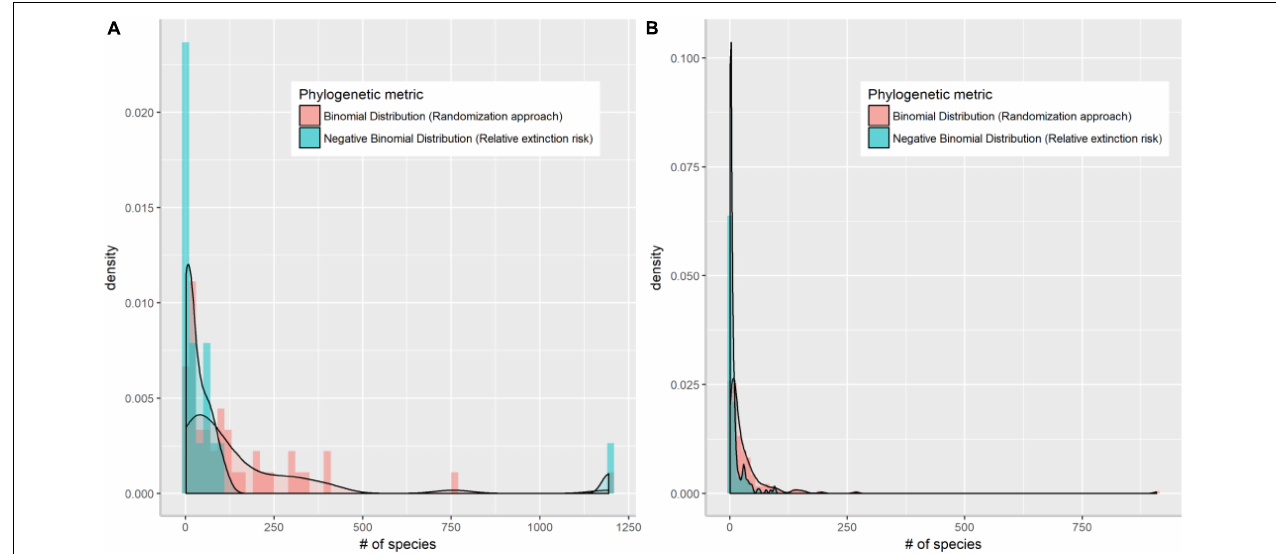
FIGURE 1 | Density plot of Chinese angiosperm families (A) and genera (B) that are identified as threatened by randomization method assuming binomial distribution (red bars) and by extinction risk assuming negative binomial distribution (blue